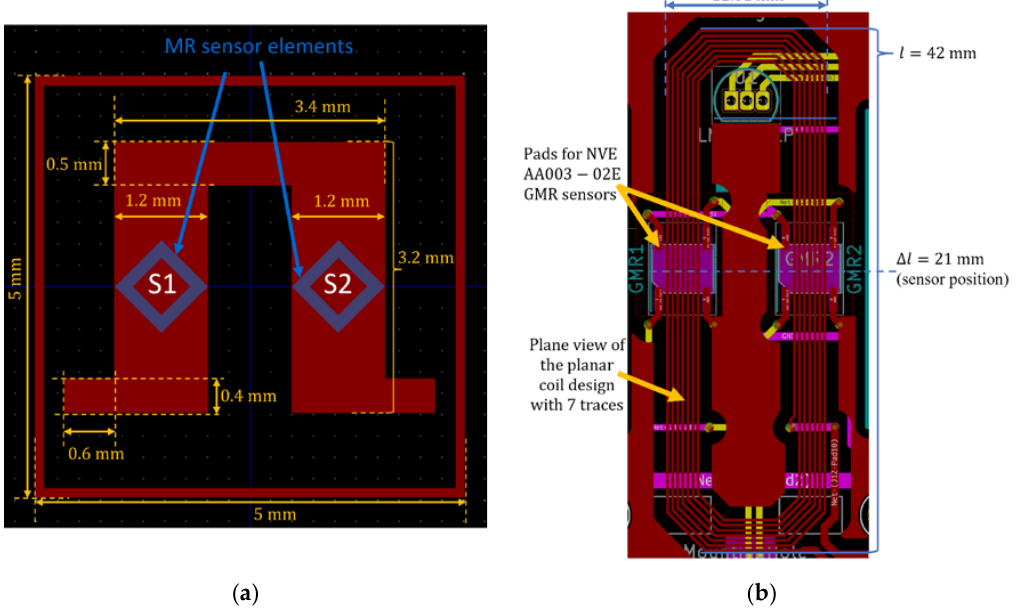
Figure 4. Design and experimental implementation of ( a ) Geometry and parameters for the U-shaped trace; ( b ) Plane view of the planar coil with seven traces.